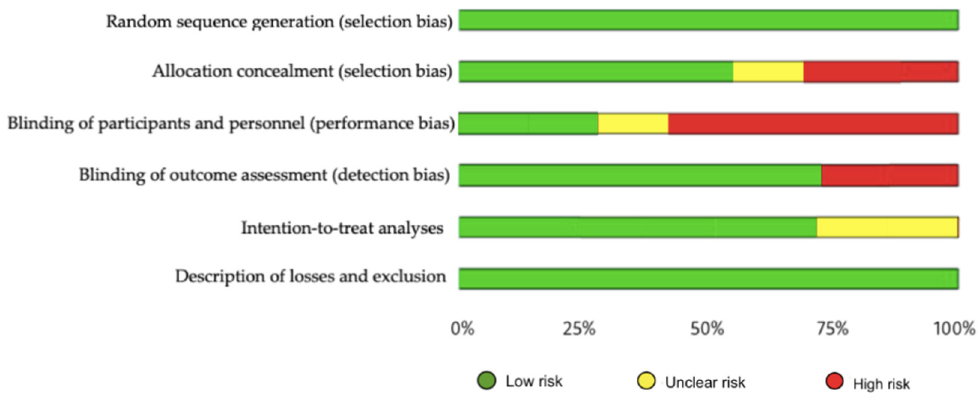
Figure 3. Risk of bias represented as percentages among all included studies.